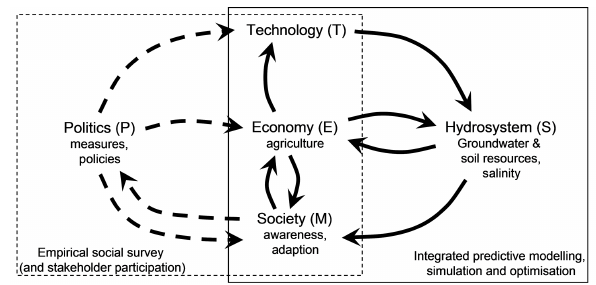
Figure 1. Schematic of system dynamics for managing saltwater intrusion in agricultural coastal